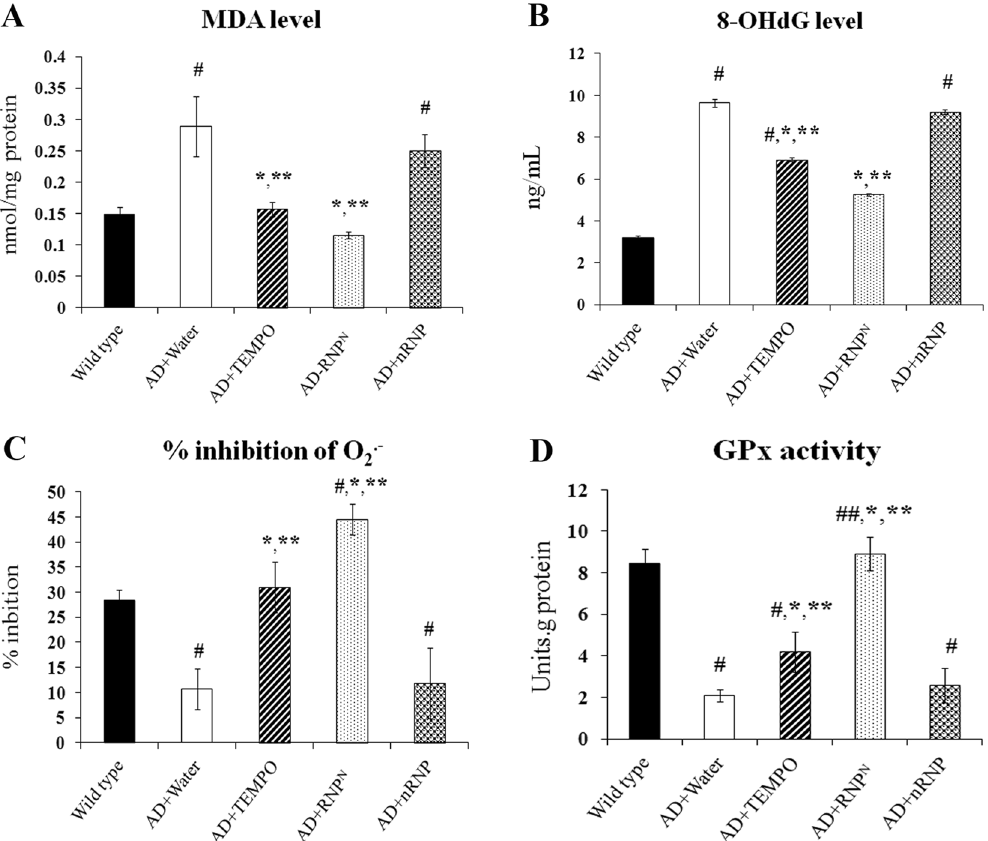
Figure 3. The oral ad libitum treatment with RNP N improves oxidative stress parameters of MDA level ( A ), 8-OHdG level ( B ), % inhibition of O 2· − ( C ) and GPx activity ( D ). Data were represented as mean ± SEM, # vs. wild type mice, p < 0.05; ## vs. AD mice treated with TEMPO, p < 0.05; * vs. AD mice treated with water, p < 0.05; ** vs. AD mice treated with nRNP, p < 0.05; n = 5